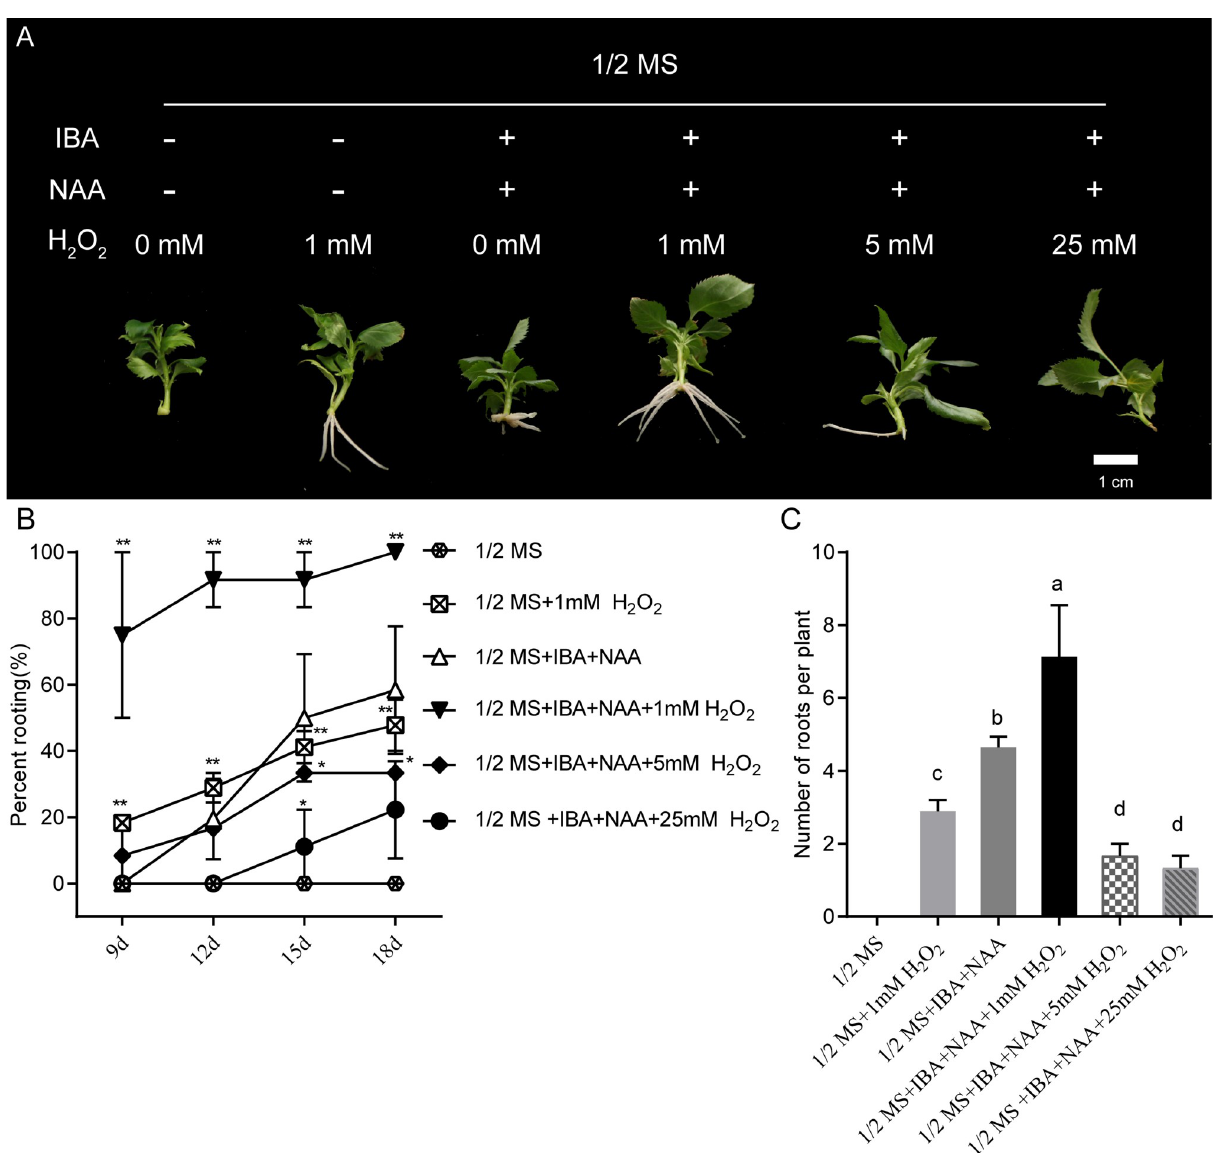
Fig 5. Effects of exogenous H 2 O 2 on adventitious root formation of apple stem cuttings. (A) Adventitious root formation in apple stem cuttings after 18 days in rooting medium or rooting medium supplemented with H 2 O 2 (1 mM, 5 mM, and 25 mM). “+” represents presence, “ − ” represents absence. The concentrations of IBA and NAA were 0.5 mg L − 1 and 0.1 mg L − 1 , respectively. (B) Percent rooting. Bars indicate mean and SE from three biological replicates; n = 6 individuals per replicate. Asterisks indicate significant differences between stem cuttings subcultured in 1/2 MS and stem cuttings subcultured in 1/2 MS + IBA +NAA (Student’s t -test, �� P < 0.01, � P < 0.05). (C) Adventitious root number per cutting. Adventitious root number per cutting was counted at 18 days. Bars indicate mean and SE from three biological replicates; n = 6 individuals per replicate. The statistical analysis was conducted using Duncan’s multiple range test ( P < 0.05). The different lowercase letters indicate significant